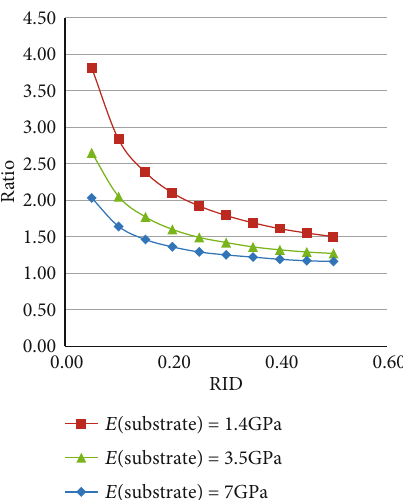
Figure 10: Ratios of Young ’ s modulus for the coating/substrate system with v (glass) equal to 0.25 and v (polymer) equal to 0.5, as a function of